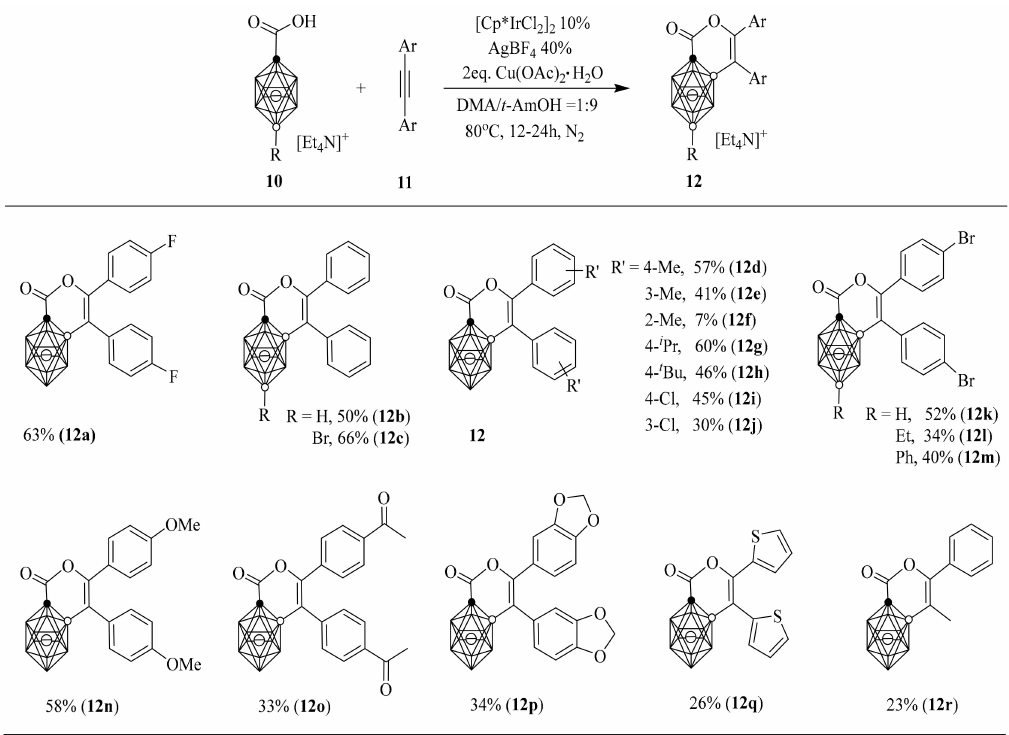
Figure 4. Synthesis of 3D analogues of